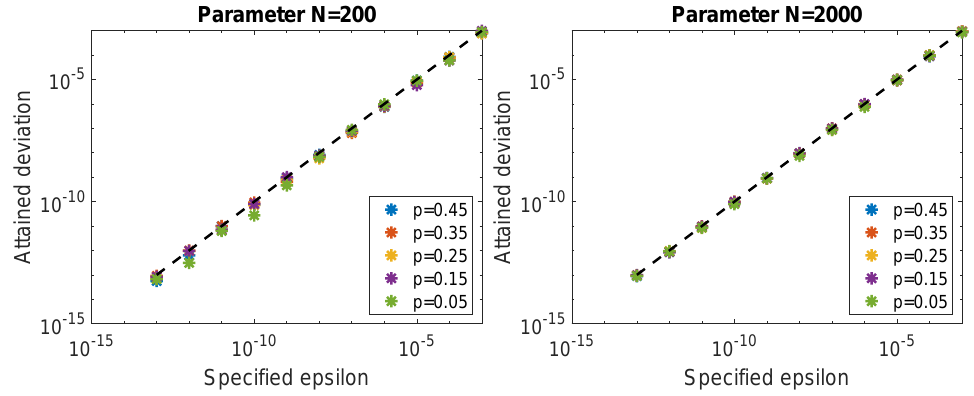
Figure 2. Specified and attained deviation for the zeroth-order function for two different segment sizes and various values of p .